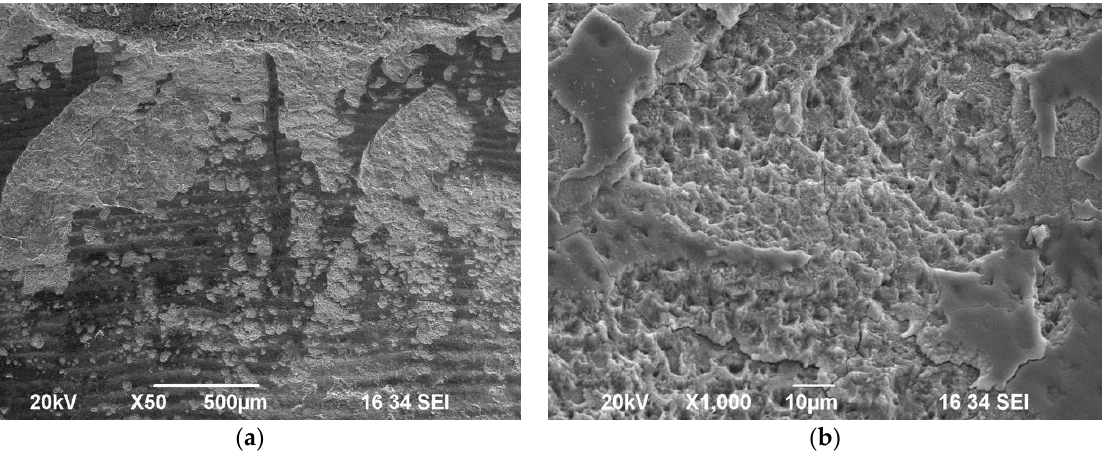
Figure 4. SEM images of enamel surface morphology following irradiation with 0.6 W/15 Hz/40 mJ/10 J/cm 2 without water spray cooling—Group D—under ×50 magnification ( a ) and ×1000 magnification ( b ), showing presence of impact craters and scaly surface.